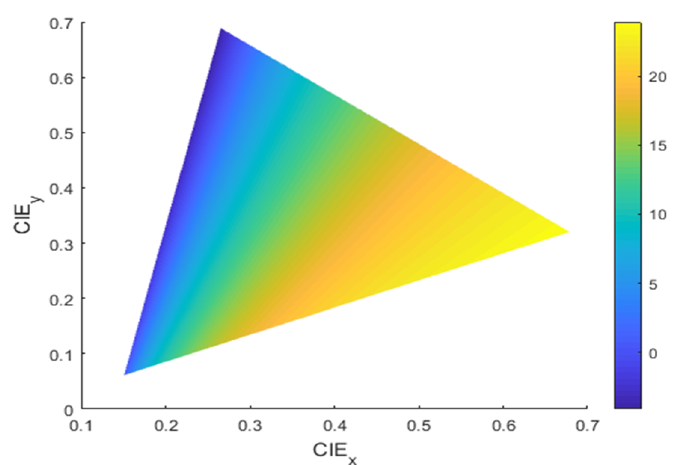
Figure 14. The decreased power consumption (unit: %) of RGB micro-LED displays with different chip sizes and uniform chip size.